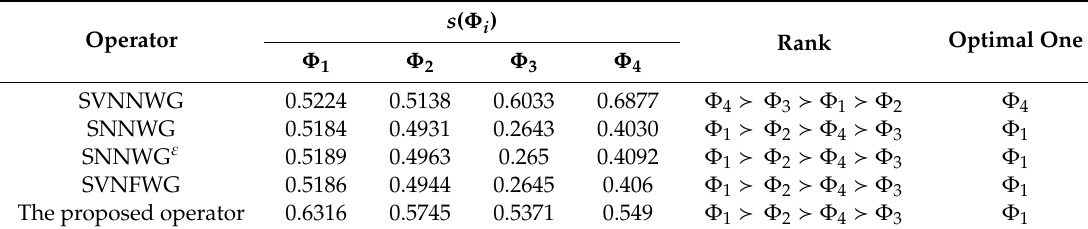
Table 2. Comparison